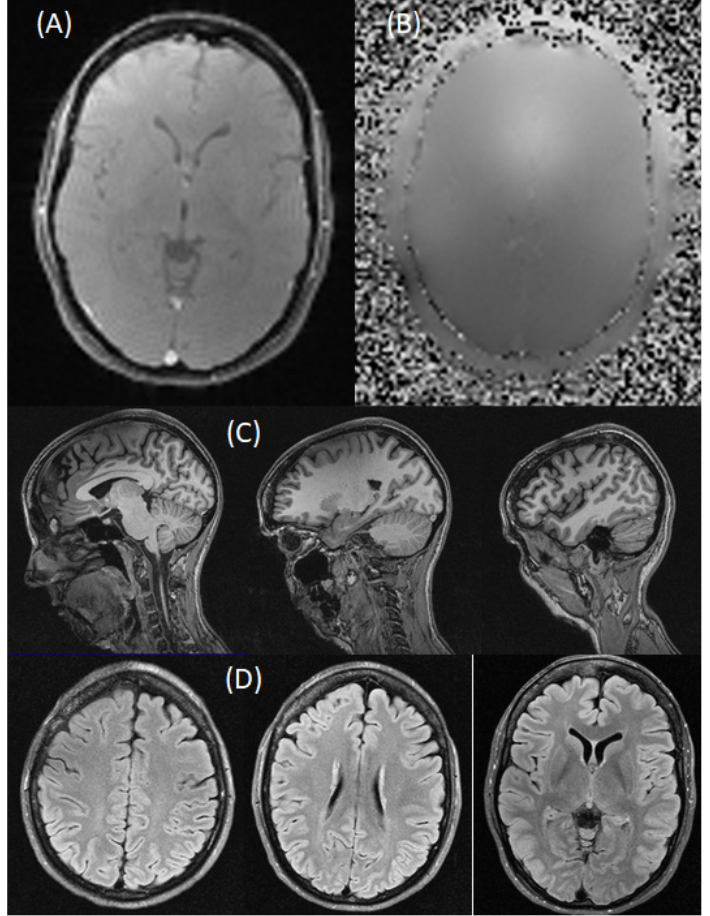
Figure 6. Three Tesla normobaric MR images. (Top) Field map images of magnitude ( A ) and phase ( B ), sagittal ( C ), and axial ( D ) T1-weighted MPRAGE images.